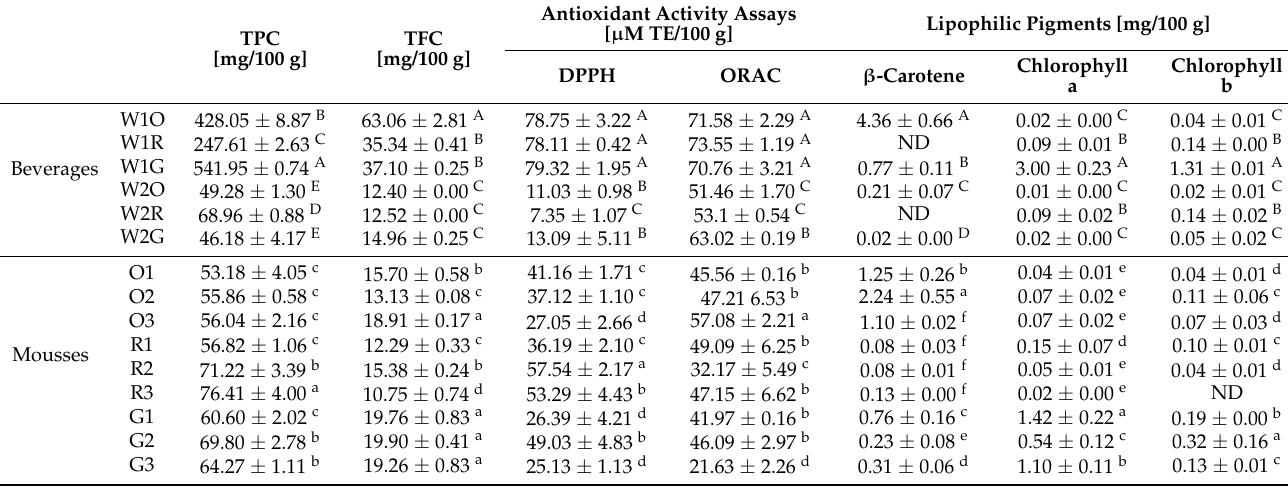
Table 1. Antioxidant properties of fruit and vegetable whey beverages and fruit and vegetable